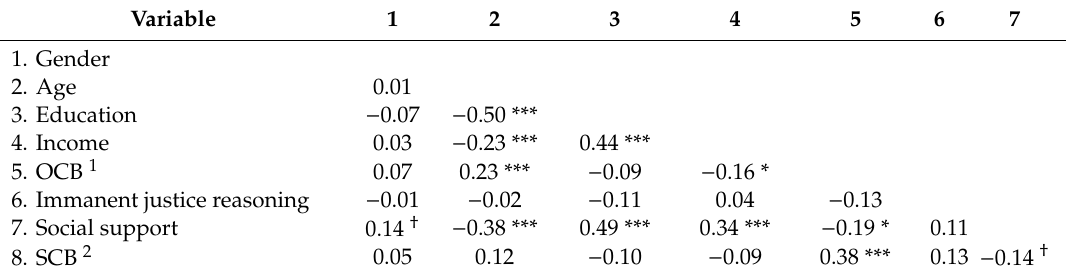
Table 2. Correlations of research variables ( N =